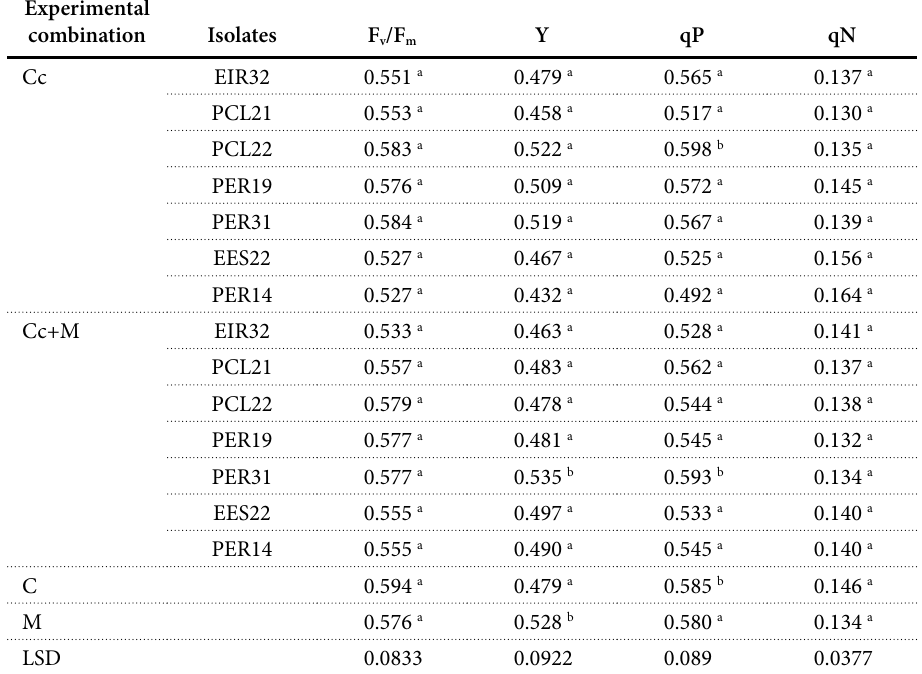
Tab. 1 Parameters of chlorophyll fluorescence in the leaves of tomato